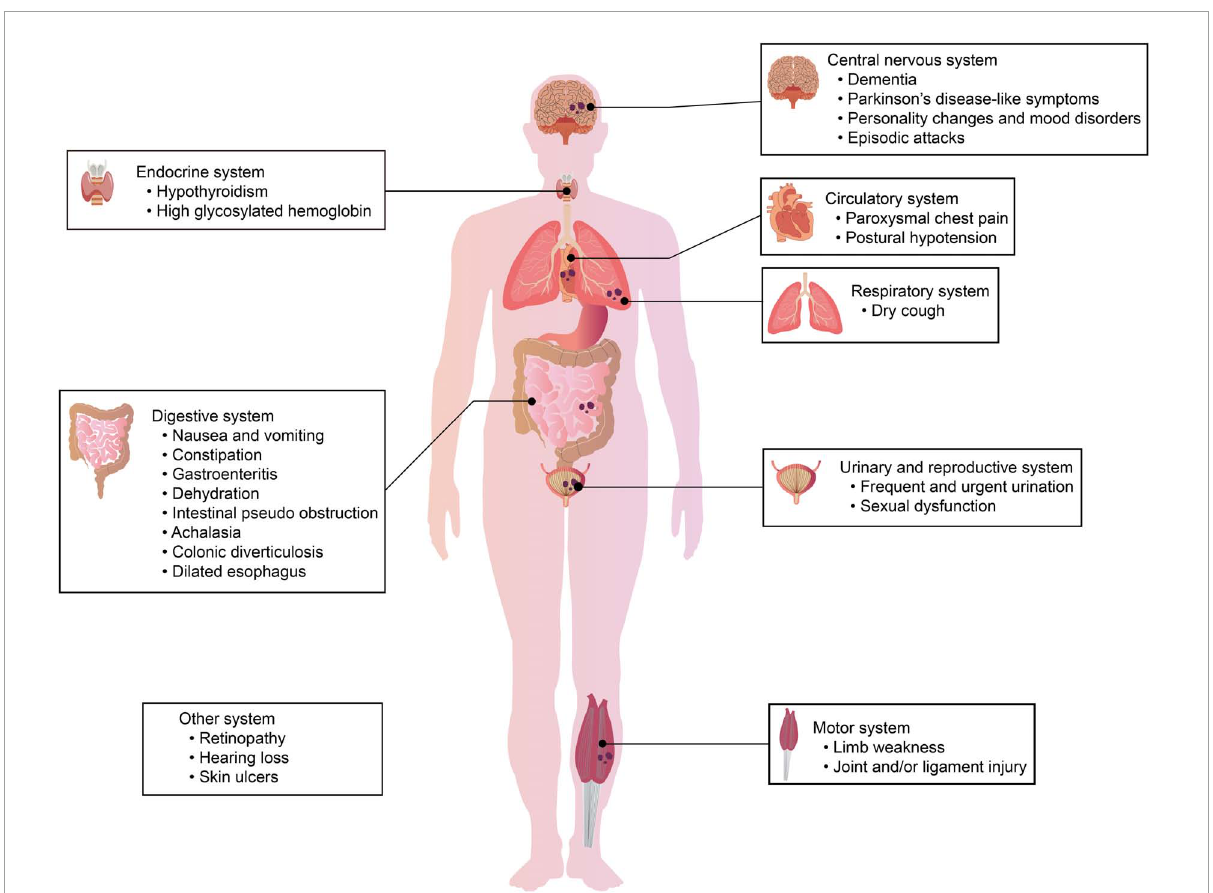
FIGURE1 Clinical symptoms in different systems of patients with NIID. The clinical manifestations of NIID are highly heterogeneous. Patients with NIID may have symptoms/signs of the nervous system and/or symptoms/signs of other systems, including the respiratory system, urinary system, digestive system, and motor